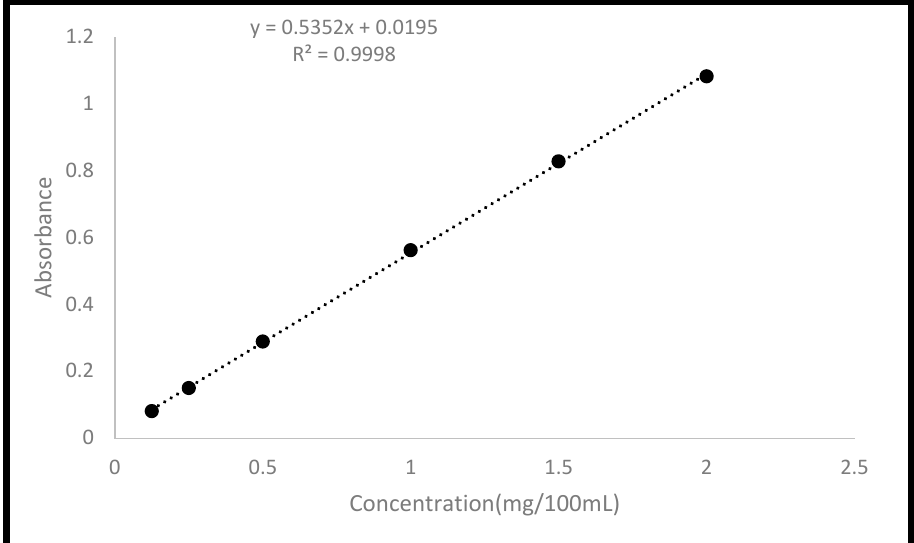
Figure 4. Calibration curve of FU in PBS.